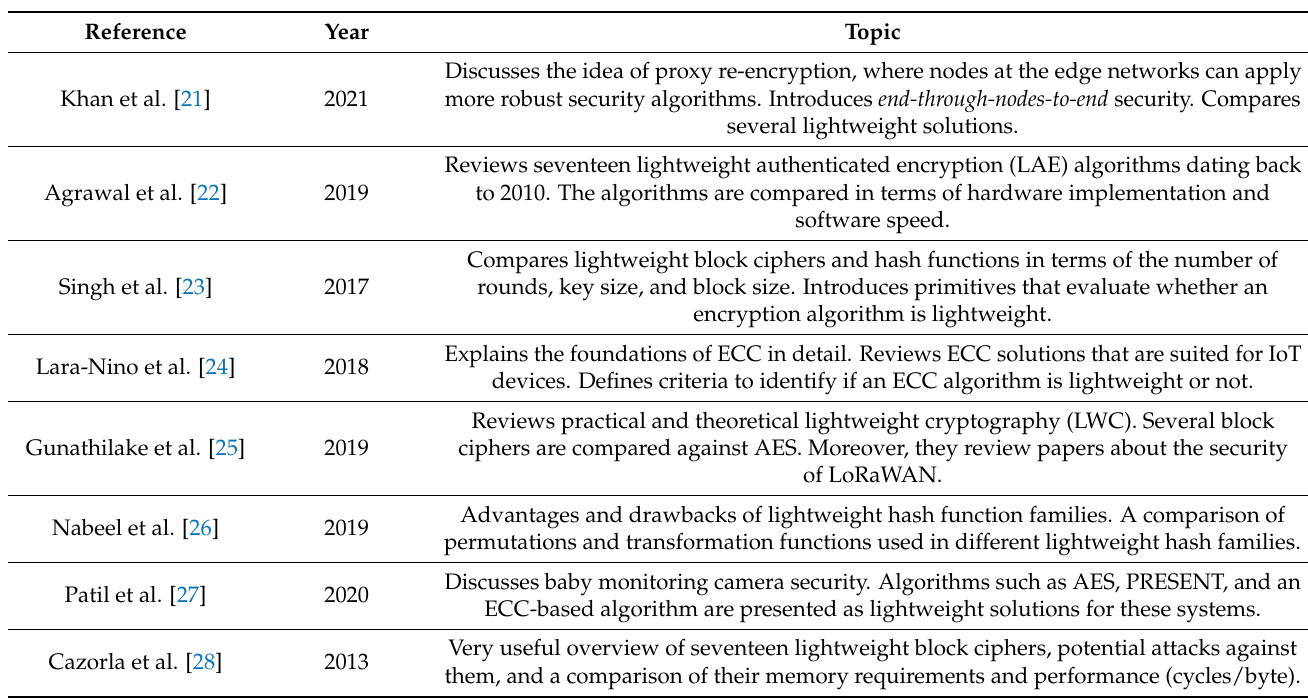
Table 2. Lightweight solutions for